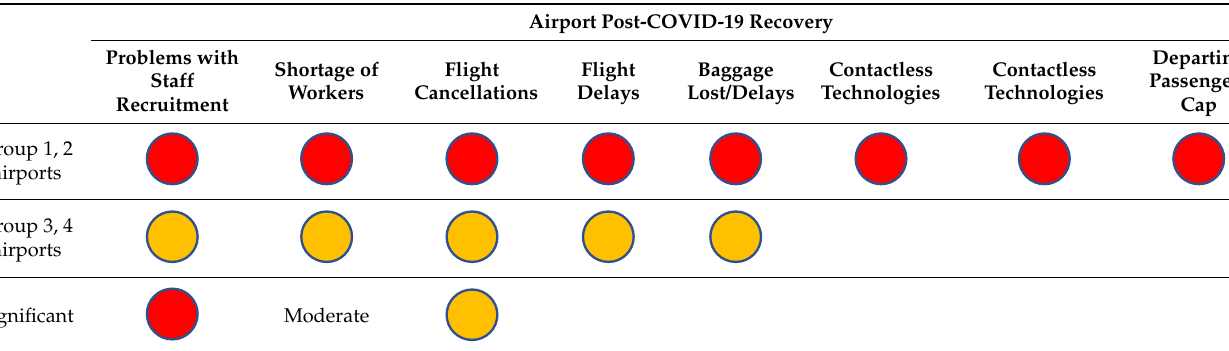
Table 2. Airport operation provisions during the post-COVID-19 recovery.